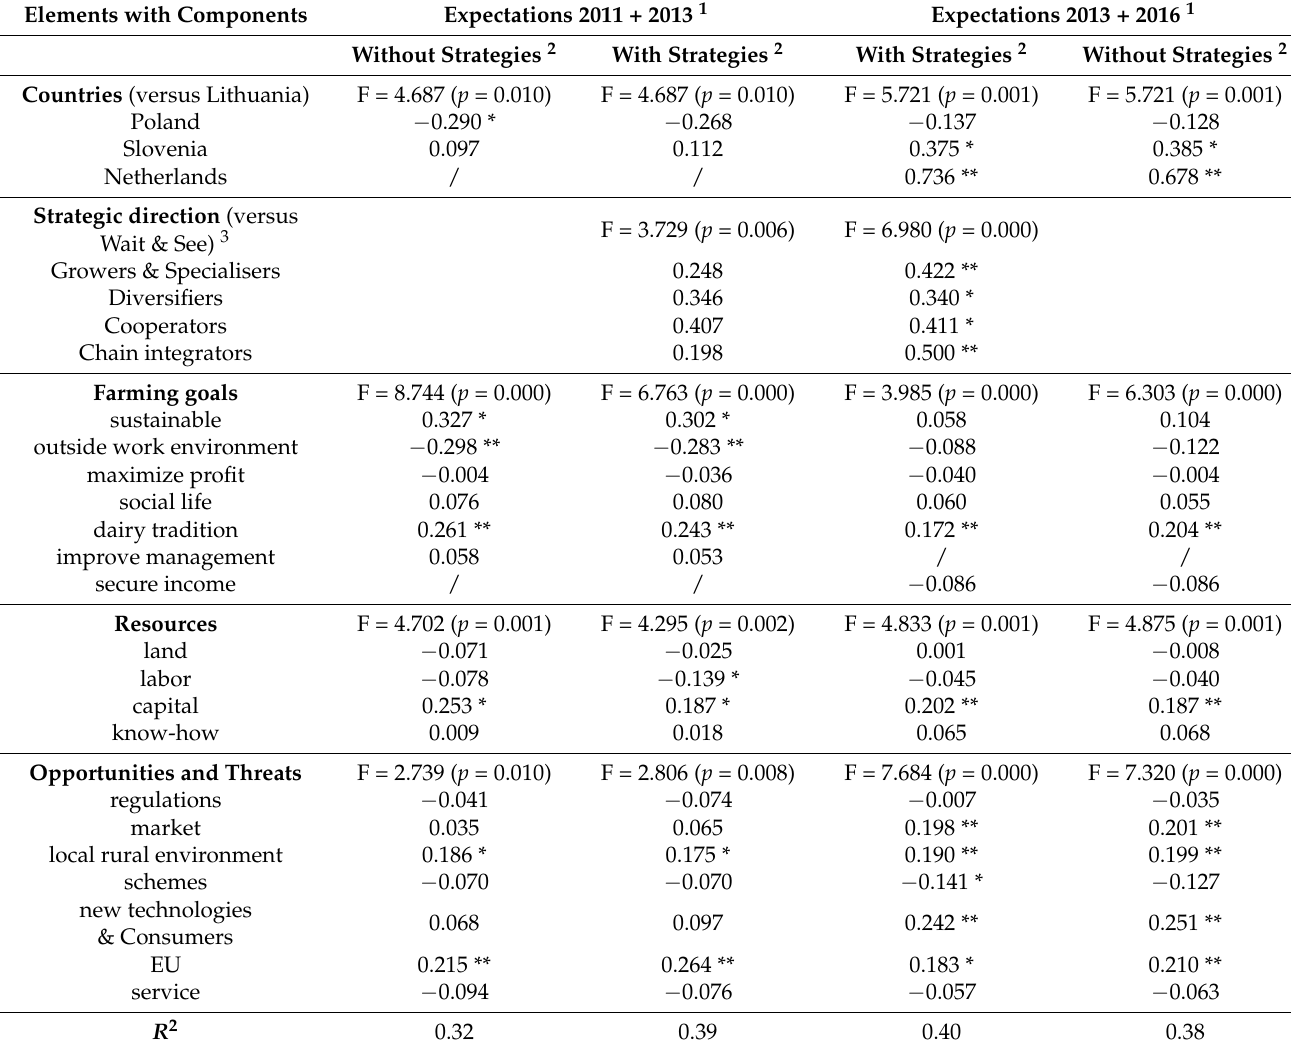
Table 8. Regression analyses of Farming goals, Resources, and Opportunities and Treats on Future prospects for mean 2011 plus 2013 and for mean 2013 plus 2016; regression coefficients (b) are listed as the change in performance per unit change in the particular component; strategic direction and countries were inserted as dummy